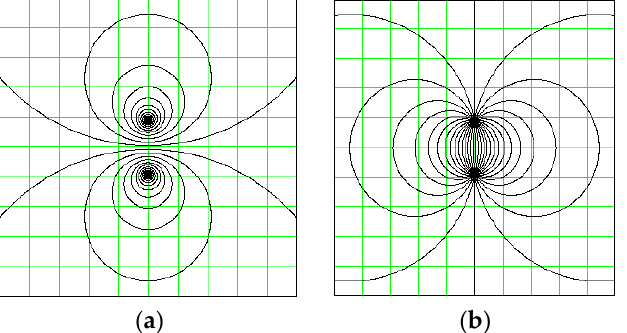
Figure 1. Level curves for bipolar coordinates: ( a ) level curves for 𝛼 = 𝑐𝑡. ; ( b ) level curves for 𝛽 = 𝑐𝑡.